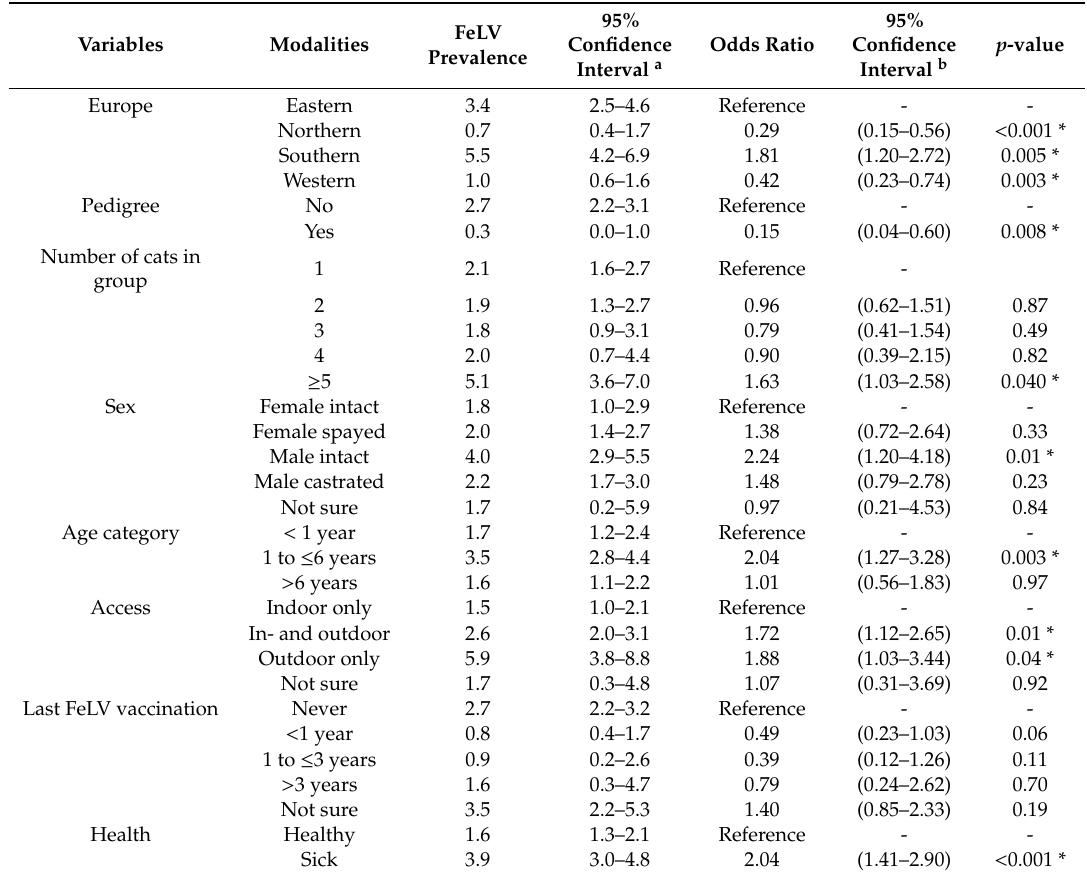
Table 4. Risk and protective factors associated with the feline leukaemia virus (FeLV) viraemia of cats after multivariate